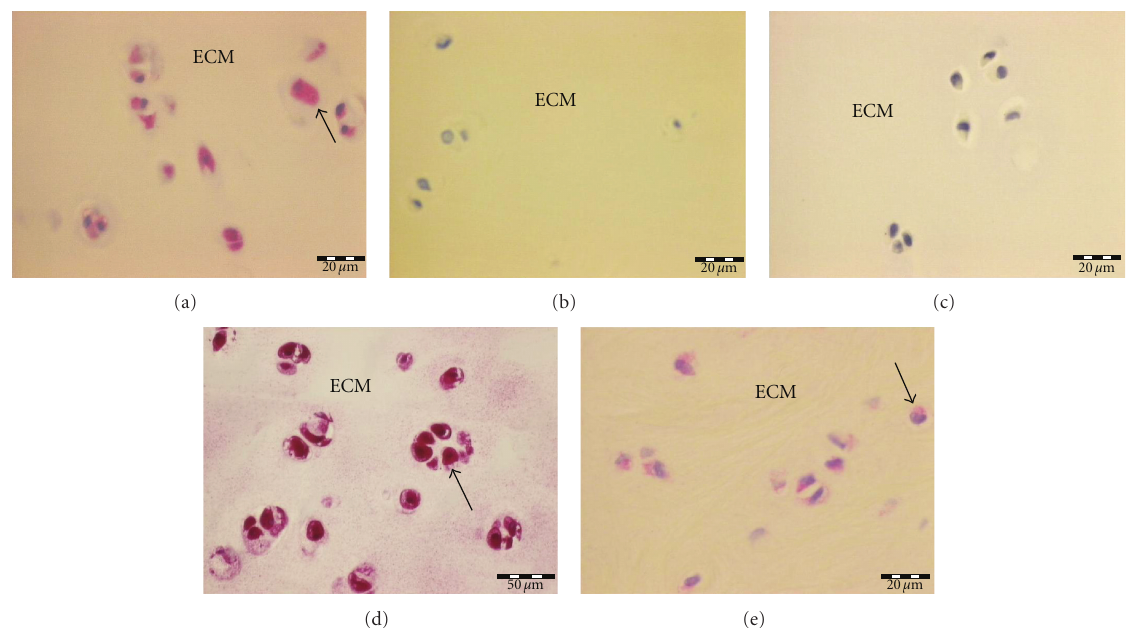
Figure 2: Immunostaining of cartilage, (a) BMPR-1A (summary score 6), (b) BMPR-1B (summary score 1), (c) BMPR-2 (summary score 1), (d) BMP-7 (summary score 6), (e) BMP-2 (summary score 4).